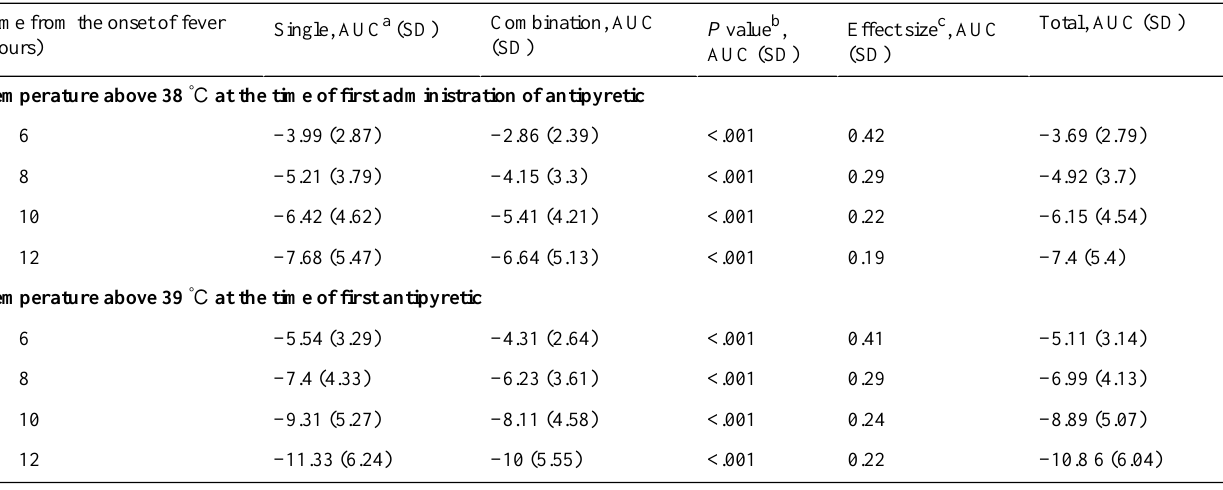
Table 2. Comparison of the area under the curve between administration patterns.